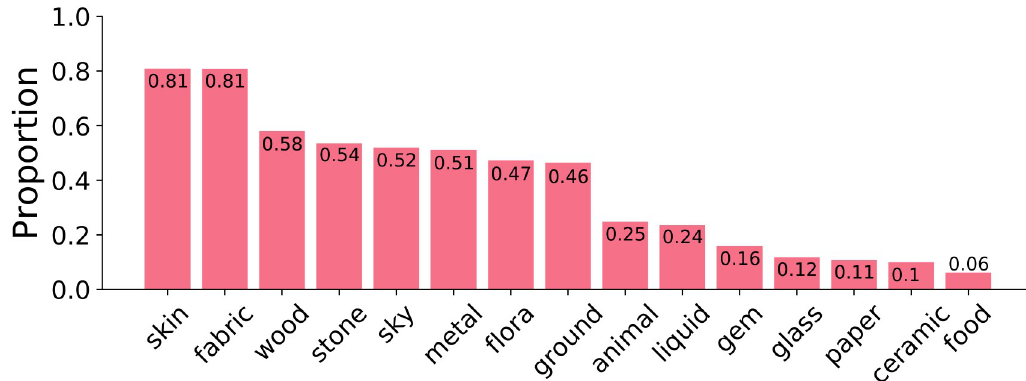
Fig 5. The proportion of paintings in our dataset that depict at least one instance of each